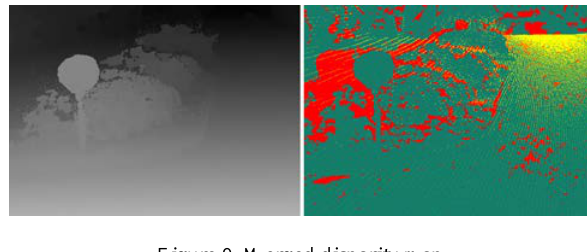
Figure 9. Merged disparity map (left = merged and interpolated, right = quality